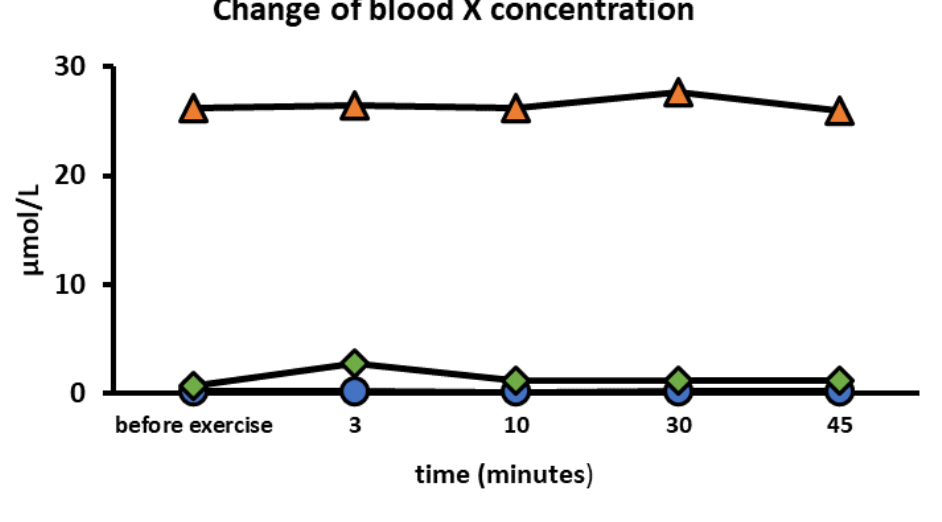
Figure 4. Changes of blood X concentration following semi-ischemic forearm exercise test. X, xan- thine.